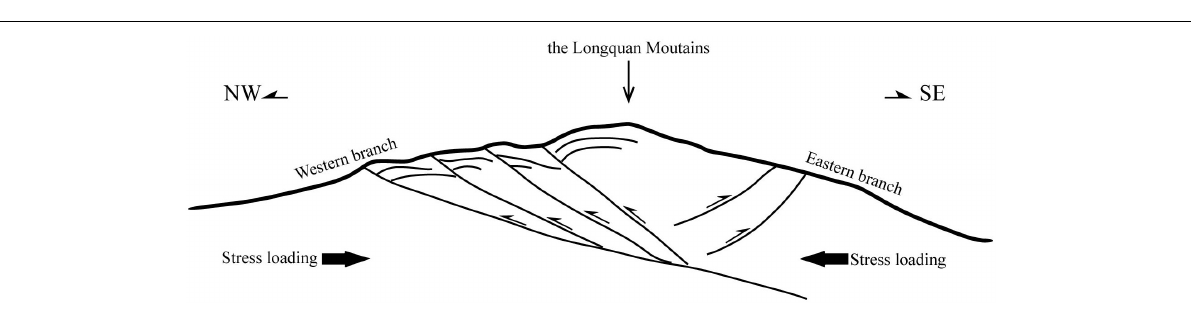
FIGURE 2 | Conceptual structural model of the Longquanshan fault zone (revised from Deng et al., 1994). The western branch consists of SE-dipping faults that form an imbricate nappe structure, with these faults converging along the same main reverse fault at depth. The eastern branch consists of NW-dipping faults with a nearly parallel